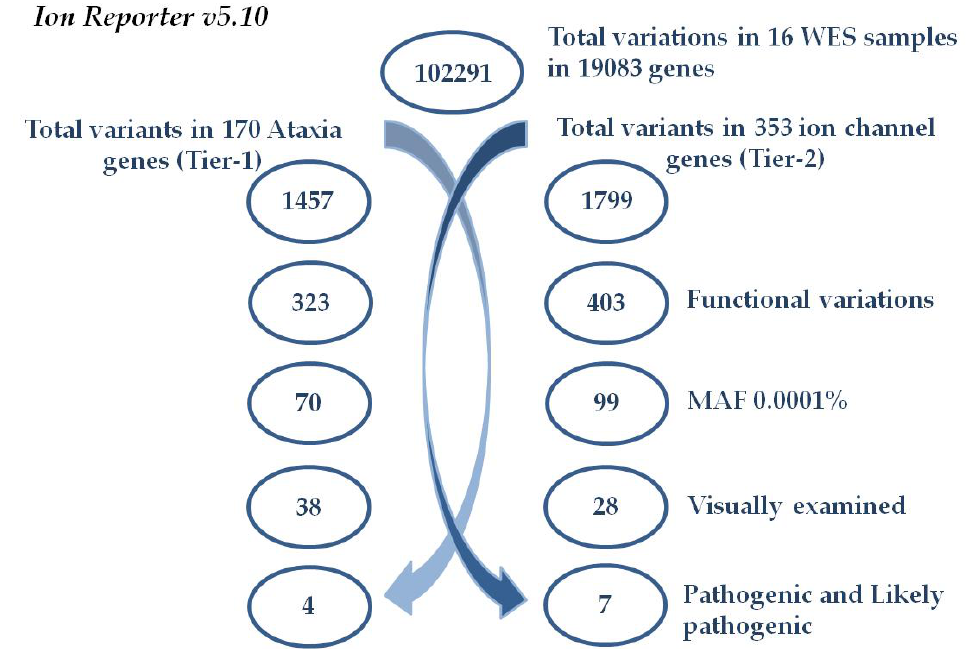
Figure 1. Variant filtering workflow using Ion Reporter v5.10.